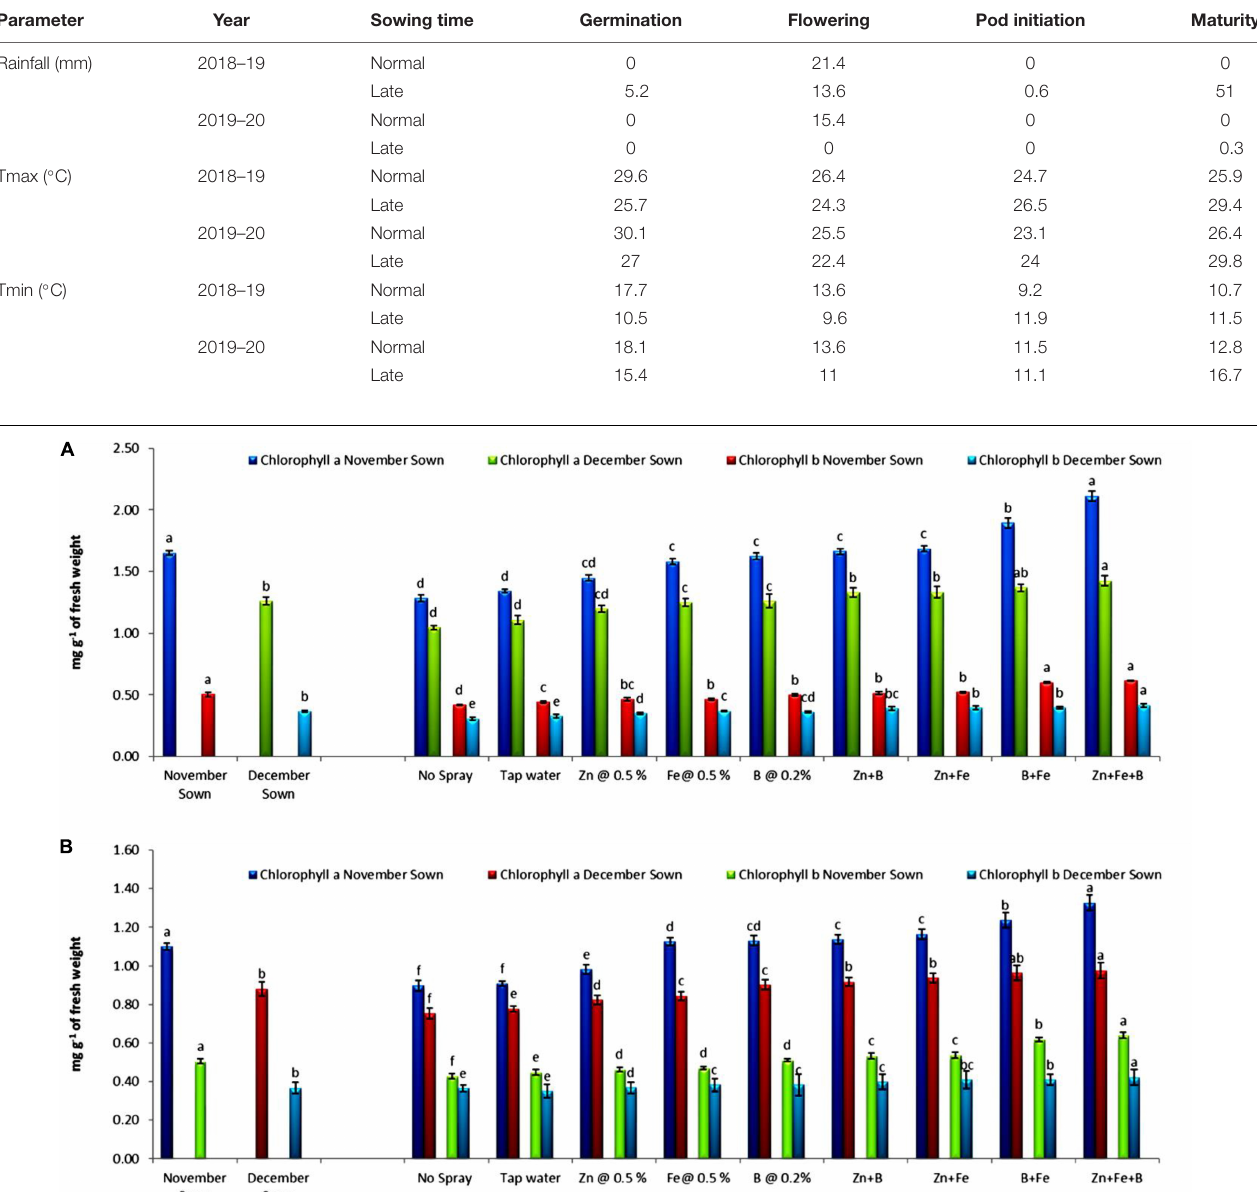
TABLE 2 | Mean rainfall and maximum and minimum temperatures during crop phenological stages. Parameter Year Sowing time Germination Flowering Pod initiation